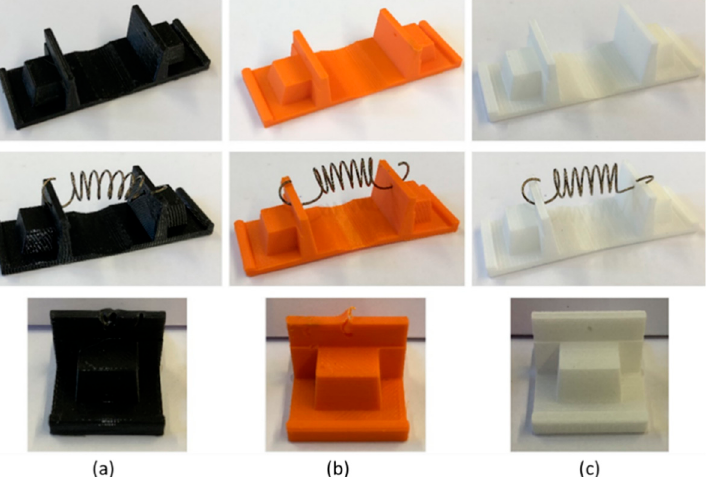
Figure 8. Visual aspect after thermal resistance tests on the supports (one spring): ( a ) PLA; ( b ) ABS; ( c ) PA12.